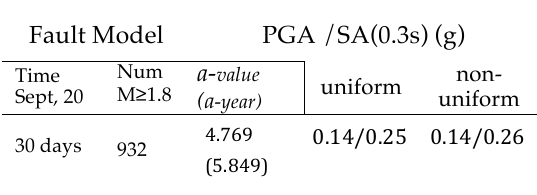
Table 2: APSHA, maximum PGA/SA at 10% probabil- ity of exceedance since Sep, 20 st , 2016, see Table 1. Fault Model PGA /SA(0.3s)